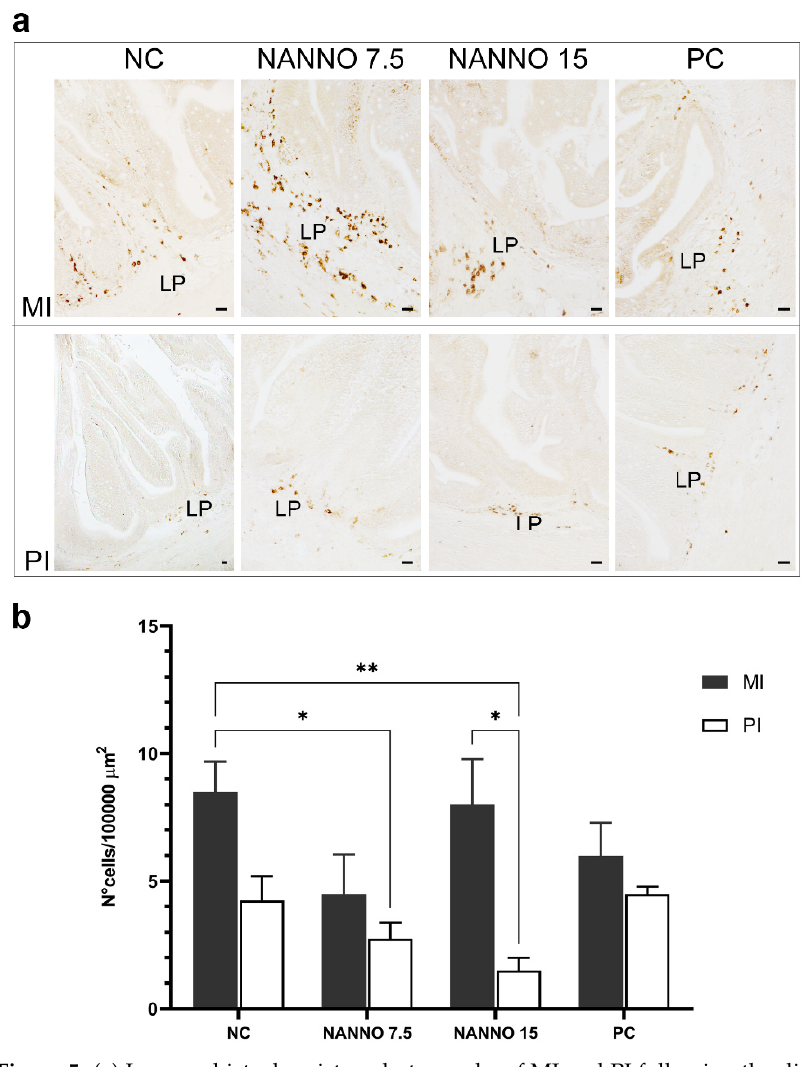
Figure 5. ( a ) Immunohistochemistry photographs of MI and PI following the dietary inclusion of Nannochloropsis sp. IHC experimental conditions are as above. LP indicates lamina propria. Scale bars are all 20 µ m. ( b ) TR γ + cells density over a 100,000 µ m 2 -area following dietary exposure to Nannochloropsis sp. * = p < 0.05; ** = p < 0.01. NC = negative control diet; NANNO 7.5 and 15 = diet formulations with 50 and 100% fish meal replacement by Nannochloropsis sp. biomass, respectively; PC = positive control diet.